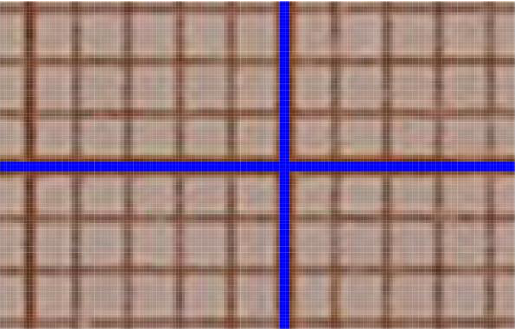
Figure 5. Camera matrix center on the background of the standard square grid (blue).